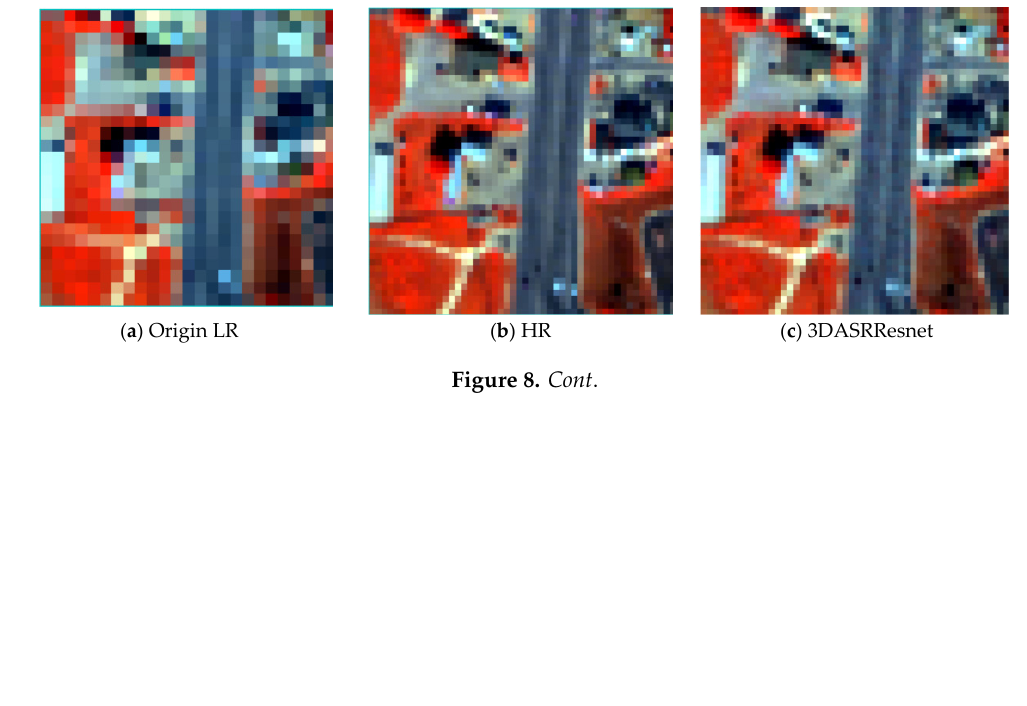
Figure 7. Results obtained from various SR HSI methods and Original LR and HR images based on the Urban dataset.